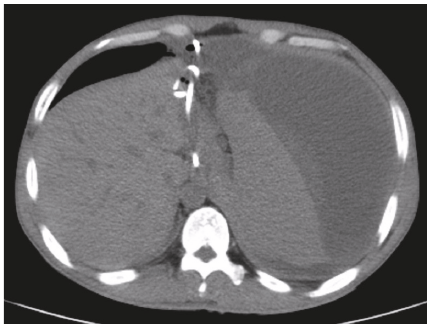
Figure 3: Vascular restructure with CT showing splenic vein dilation and expansion of portal vein branches.